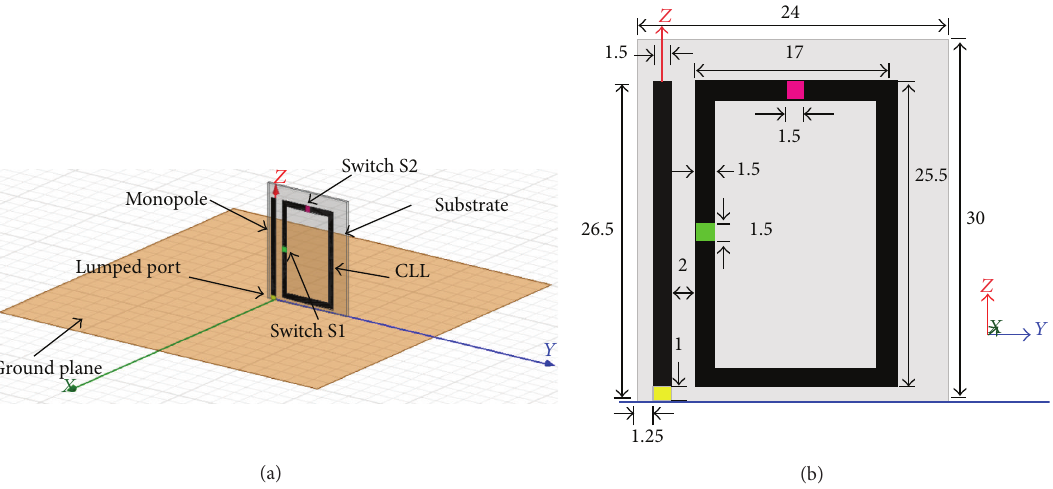
Figure1:(a)Simulationmodelofthesingle-CLL,two-gapelement-basedreconfigurableantenna,and(b)geometryoftheindividualelements (dimensions in